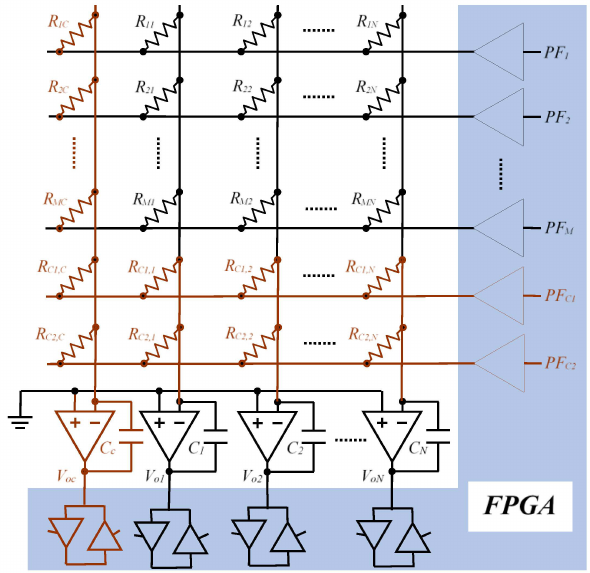
Figure 7. Proposed modification to evaluate the effect of the offset voltages and polarization currents of the